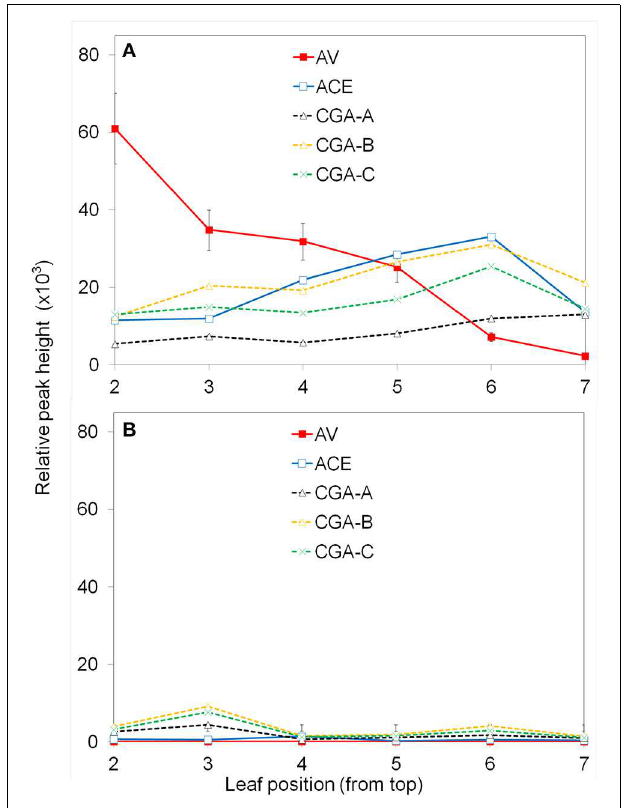
FIGURE 2 | Effect of leaf age on production of apoplastic phenolics in response to P. fluorescens . Leaves were numbered from the top down as described in the Materials and Methods. The leaf segments were inoculated with 10 8 CFU ml − 1 P. fluorescens (A) ; control segments were inoculated with water (B) . After 6h the segments were analyzed for phenolic content using UPLC/UV/MS. See Materials and Methods for further details; AV (acetovanillone); ACE (acetosyringone); CGA (chlorogenic acid isomers).